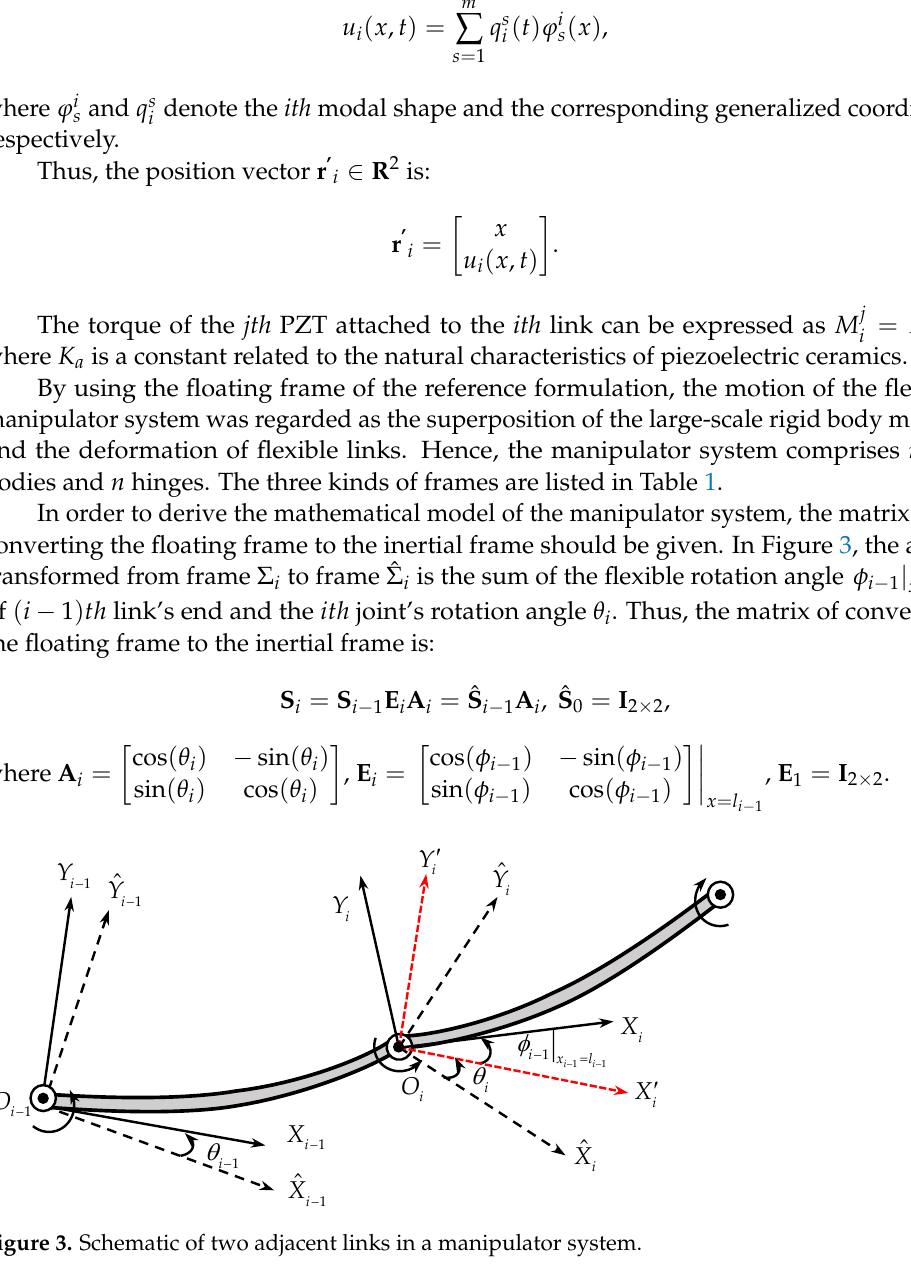
5 of 27 Figure 2. Schematic of the joint model.   = − i i i .